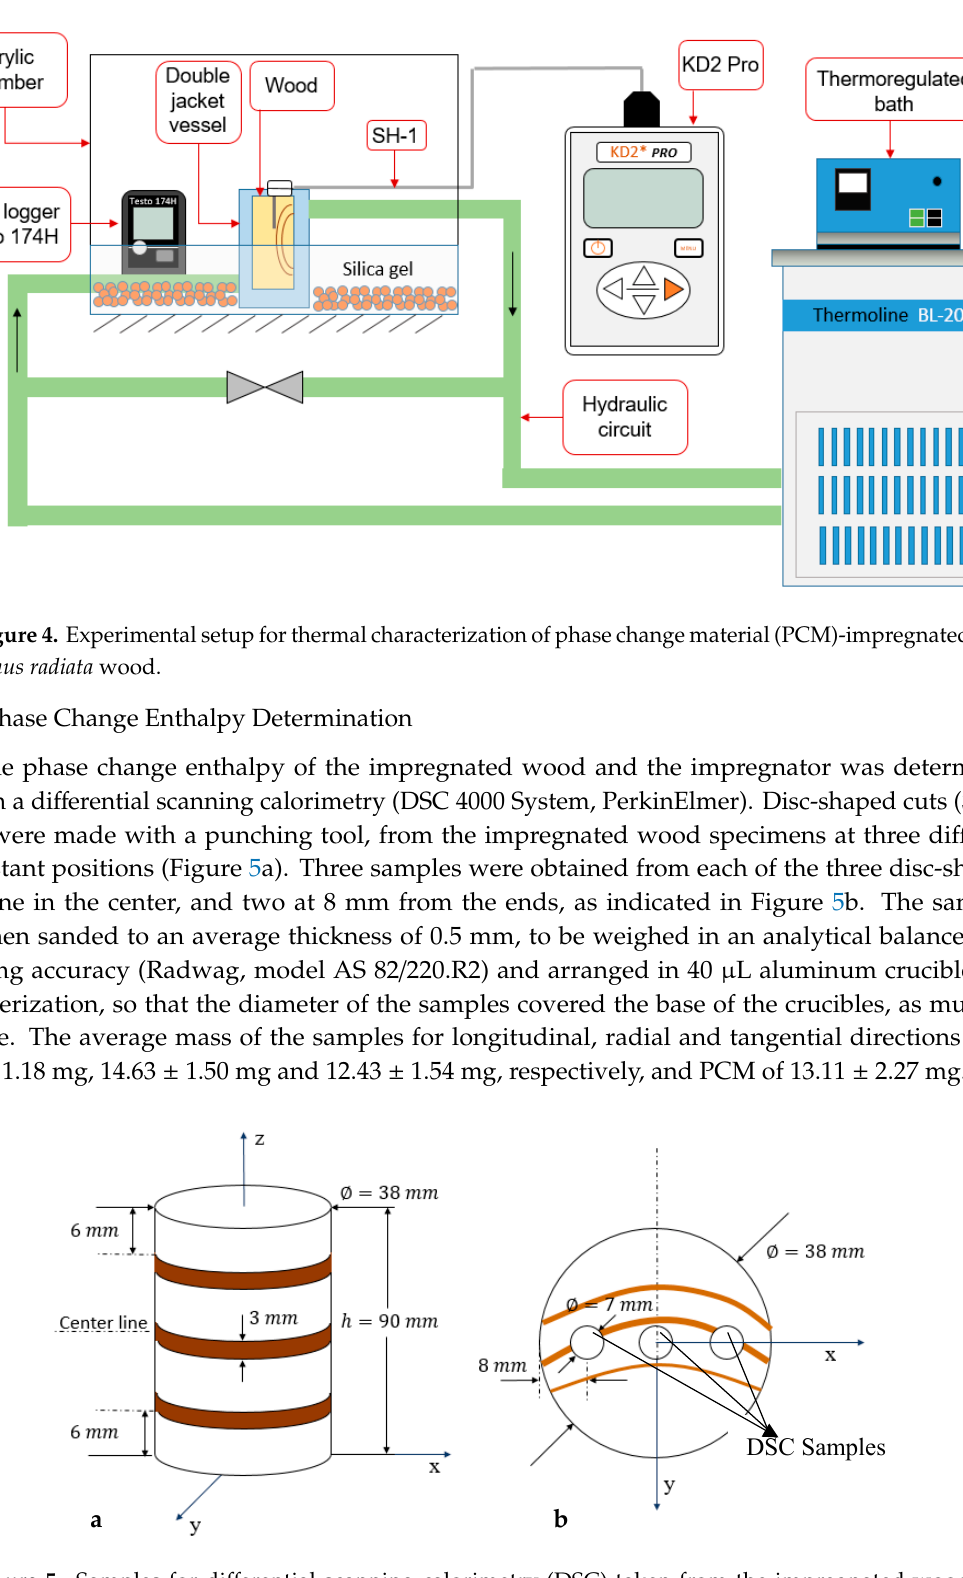
Figure 5. Samples for differential scanning calorimetry (DSC) taken from the impregnated wood specimens. ( a ) Disc-shaped cuts of a sample and ( b ) DSC samples from each disc-shaped cut.